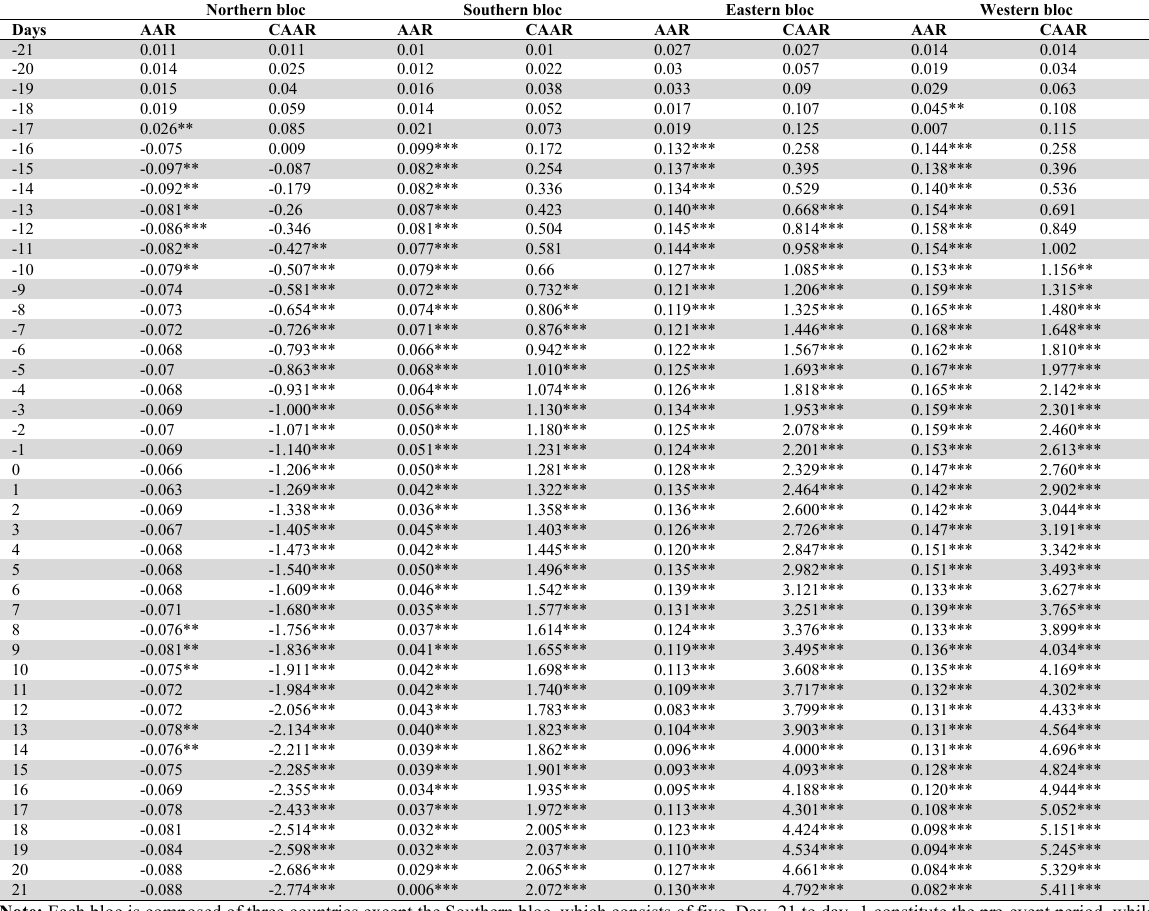
AARs and CAARs 21 days before and 21 days after the event of WHO announcement Northern bloc Southern bloc Eastern bloc Western bloc